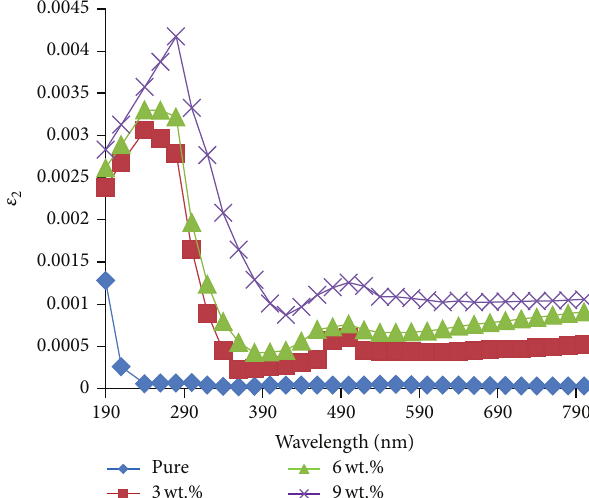
Figure 14: Imaginary part of dielectric constant of PVAc/0, PVAc/3, PVAc/6, and PVAc/9 wt.% of [Co(NH 3 ) 5 Cl]Cl 2 composites versus